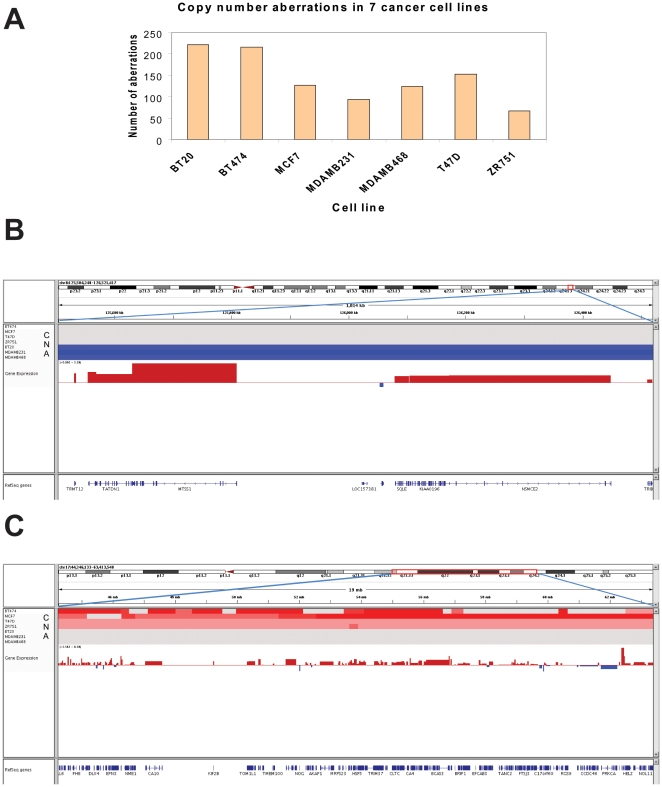
Gene copy number aberrations are associated with differential gene expression.
Panel A: A histogram of the number of statistically significant CNAs identified in each cell line. Panel B: IGV (Integrative Genomics Viewer) view of copy number aberrations for the region of chromosome 8 that is deleted in all three ER− cell lines. Panel C: Genomic view of copy number aberrations for the regions of chromosome 17 with amplification in all four ER+ cell lines. The symbols and abbreviations in Panels B and C are as follows: CNA - the copy number aberration track for each individual cell line; red represents amplification, blue deletion, and gray no change. Gene expression – the differential gene expression track; red represents overexpression in ER+ cells, blue represents overexpression in ER− cells, shown as log2 fold change.